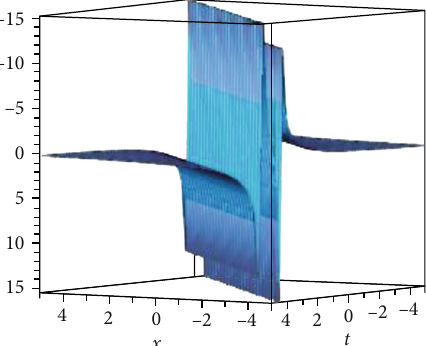
Figure 3: 3D graph of V = 1 represent the exact traveling wave z 1